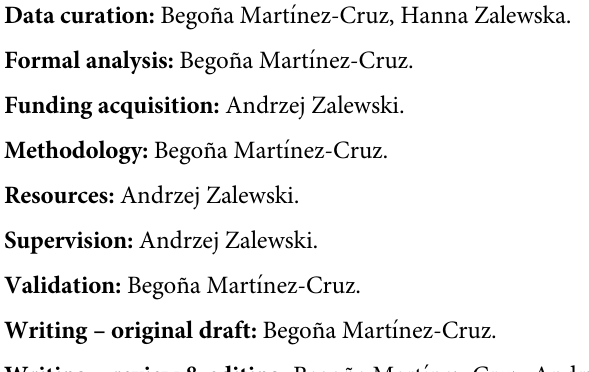
S3 Table. Description of the microsatellites tested and used, and tested but not used in this study. A) Number of alleles, He and Ho values for the eleven microsatellites for all the samples in this study. B) List of microsatellite markers tested but not finally used in this study. S4 Table. Microsatellite genotypes of the individuals used in this study. S5 Table. A- mtDNA haplotypes found in this study. B- Distribution of the Haplotypes in the populations. S6 Table. FST values among populations estimated with the 11 microsatellite markers. S7 Table. Phist, and Phist and pairwise differences p-values among populations estimated with the fragment of mitochondrial control region sequenced in this